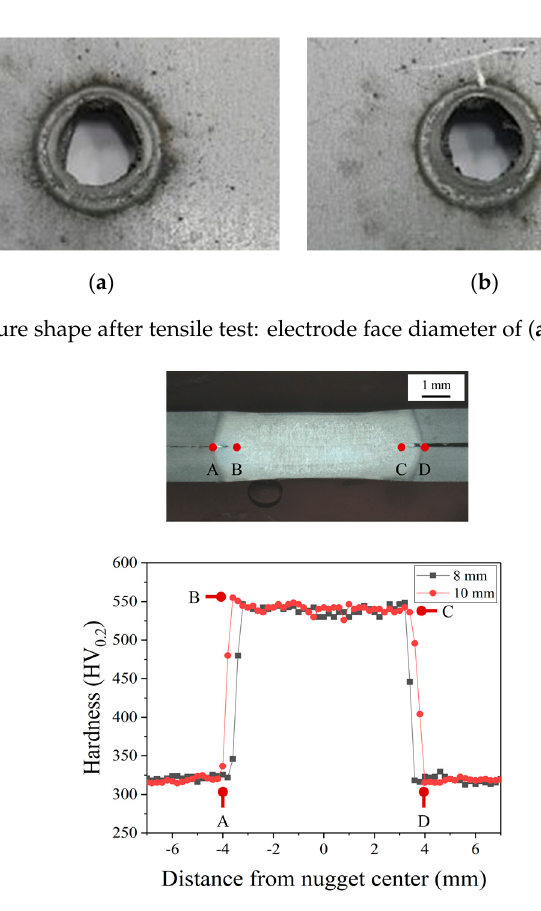
Figure 4. Vickers hardness profile of welded specimens using the electrodes with different diameters.